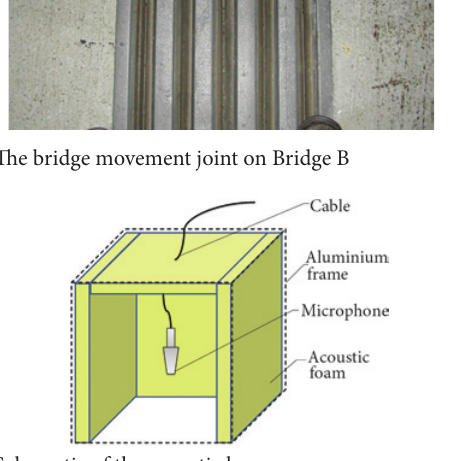
Fig. 7. Schematic of the acoustic box